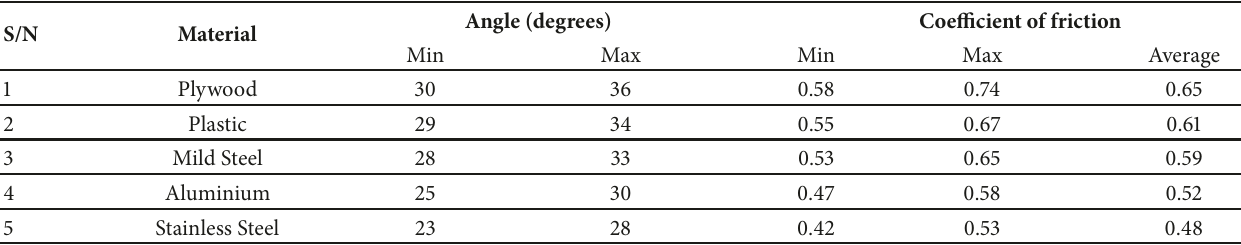
Table 6: Coefficients of friction for un-threshed beans pods.